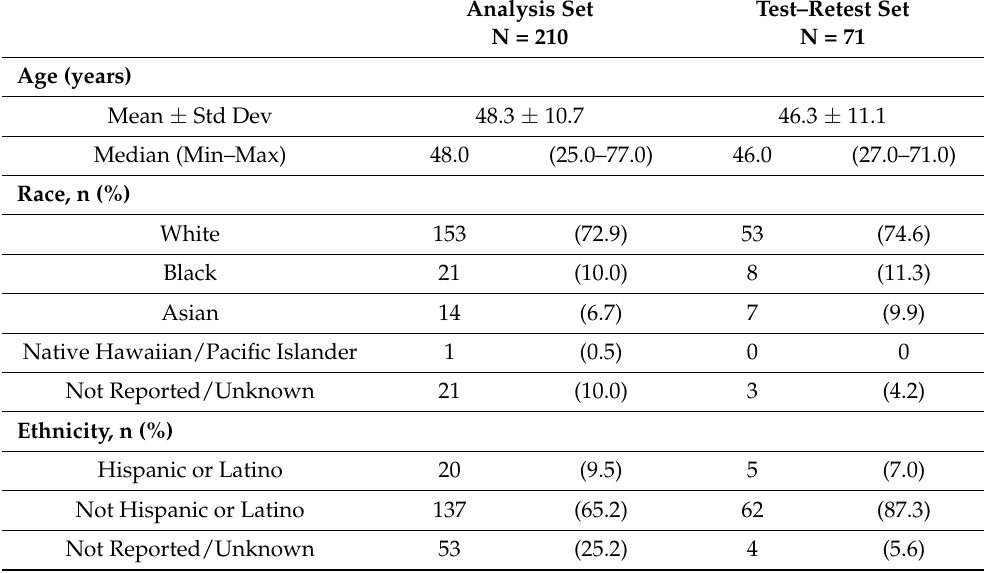
Table 1. Patient